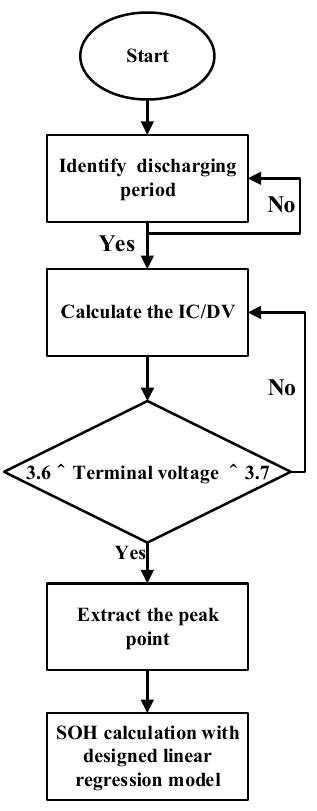
Figure 15. Block diagram of the linear regression model ‐ based SOH estimation.